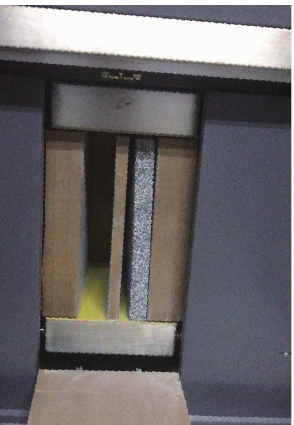
Figure 13. Thermal conductivity test of the GCIB.